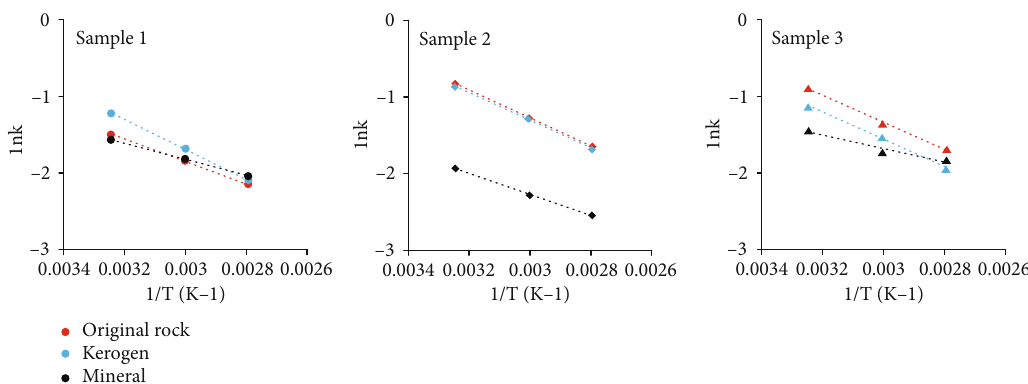
Figure 3: The adsorption thermodynamics parameter obtained by the linear relationship between ln (K) and 1/T (inverse of Kelvin